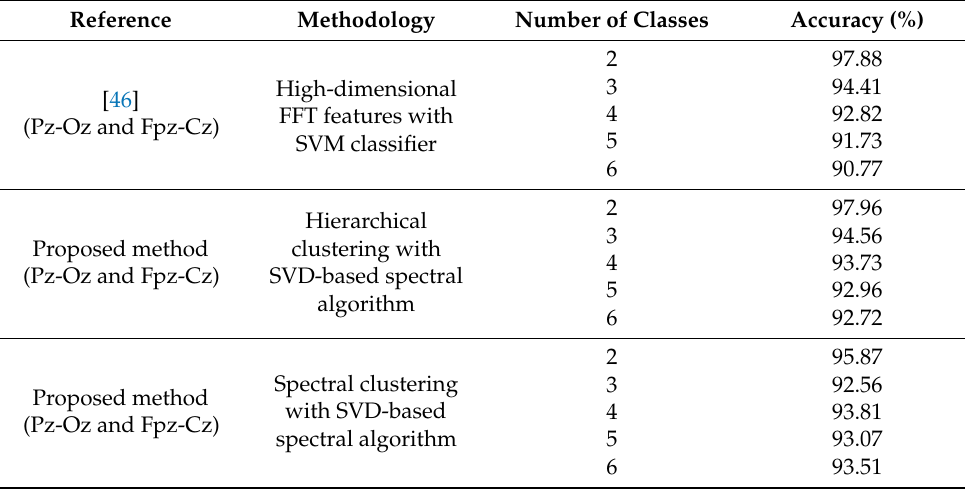
Table 9. Comparison with previous works for two channels (Pz-Oz and